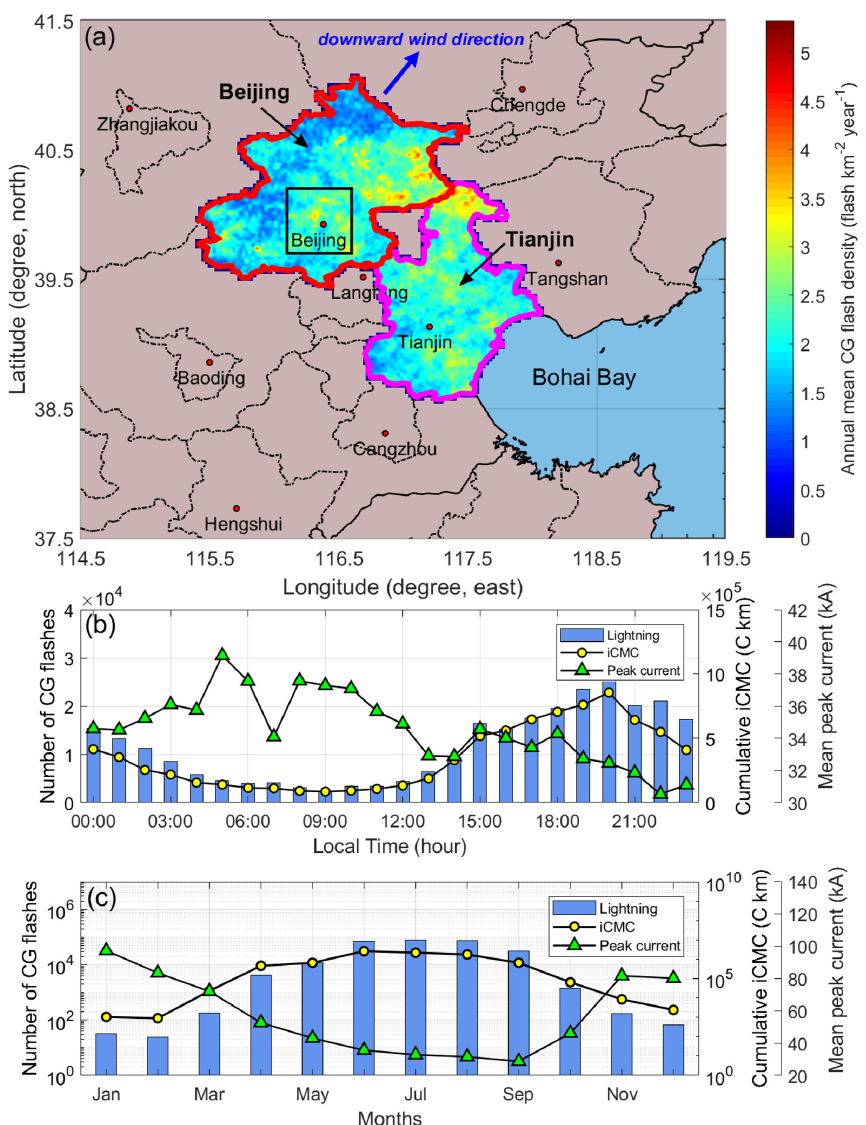
Figure 2. ( a ) Geographical distribution of the cloud-to-ground (CG) flash density. The black rectangle indicates the downtown of Beijing. ( b , c ) Diurnal and monthly variation of CG flash number, mean peak current, and cumulative impulse charge moment change (iCMC). Figure 3 shows the geographical distribution of the positive and negative CG flash density in the research region, with significant differences. The negative CG flashes mainly occurred in the downtown and northeastern of the city, whereas the distribution of the positive CG flashes was relatively scattered. The cloud microphysical processes that generate electric charge cannot be analyzed due to the lack of corresponding du- al-polarization radar data. Existing results show that the charge reversal temperature will shift to higher temperatures when the cloud droplets contain available air pollutants [3]. Therefore, the main negative charge region can extend to the base of the cloud and cover the positive charge center below, thereby generating more negative CG flashes. For small-size graupel/ice crystals, they are better able to migrate from urban areas to sub-